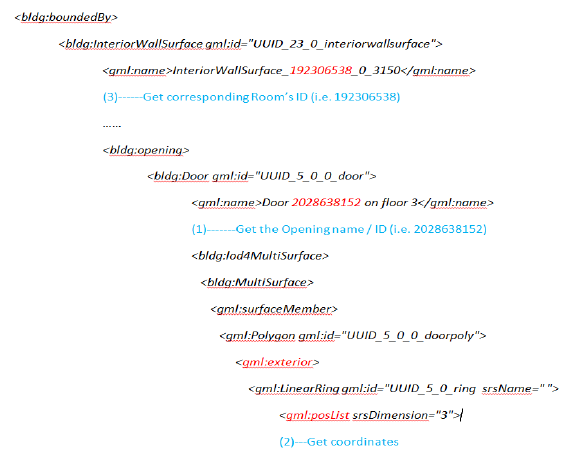
Figure 2. A fragment of the reconstructed CityGML LOD4